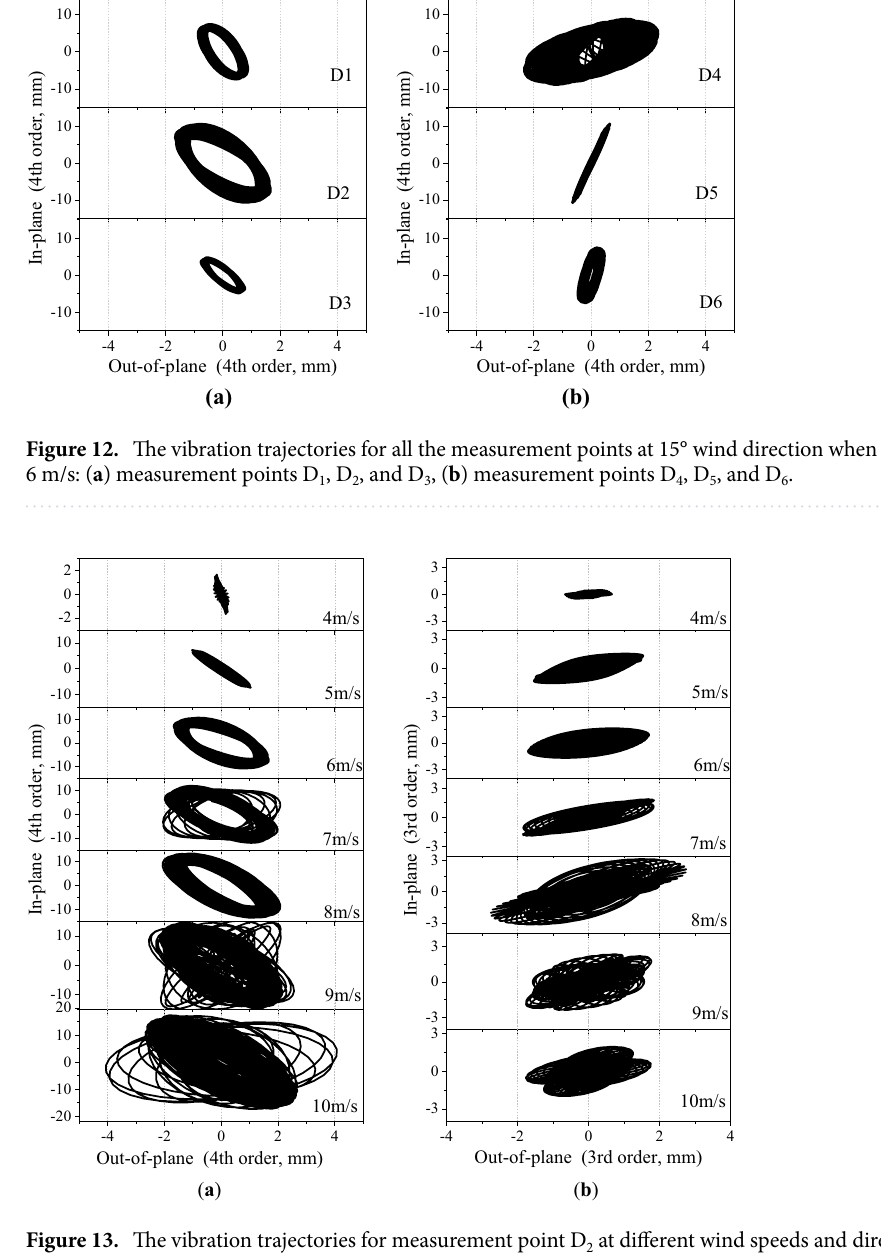
Figure 13. The vibration trajectories for measurement point D 2 at different wind speeds and directions: ( a ) 15° wind direction. ( b ) 30° wind